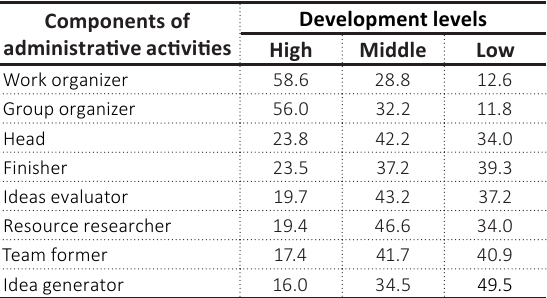
Table 2. Levels of development of the main roles in the management team of heads of educational institutions (% of the total number of